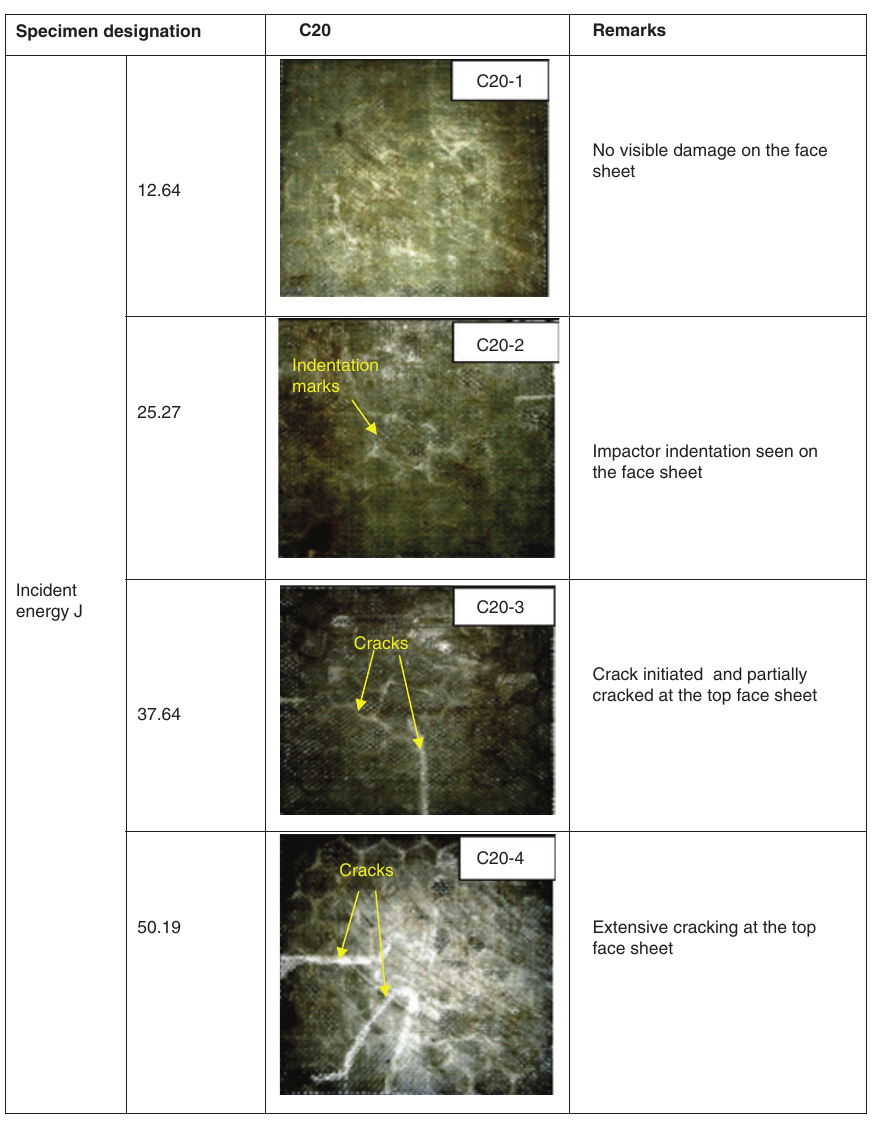
Figure 13 Post-impact images of specimen C20 at various energy